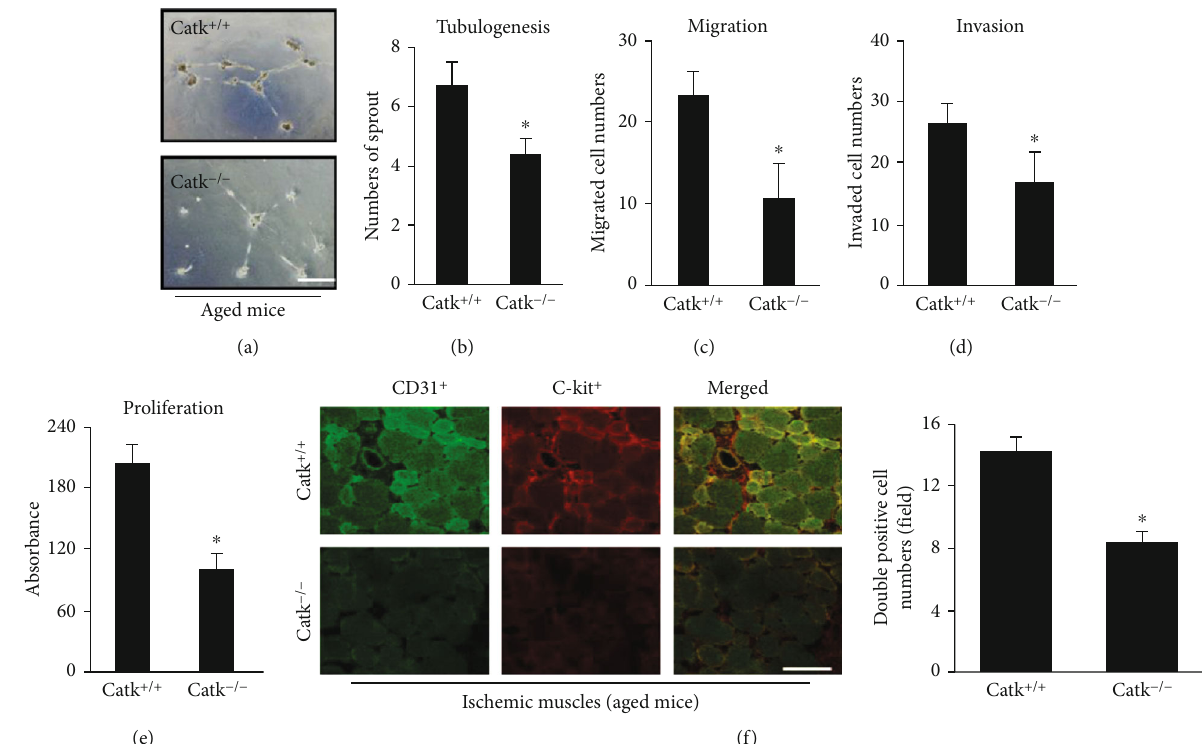
Figure 4: CatK de fi ciency reduced bone marrow-derived c-Kit + cell angiogenic actions in aged mice. (a – e) c-Kit + cells isolated by magnetic beads were applied to the tubulogenesis, migration, invasion, and proliferation assays. (f) Representative immuno fl uorescence and quantitative data show a reduction of CD31 + c-Kit + double-positive cells in the ischemic muscles of aged CatK − / − mice compared to aged CatK +/+ mice. Scale bar: 50 μ m. ∗ p < 0 : 01 by Tukey ’ s post hoc test or Student ’ s unpaired t